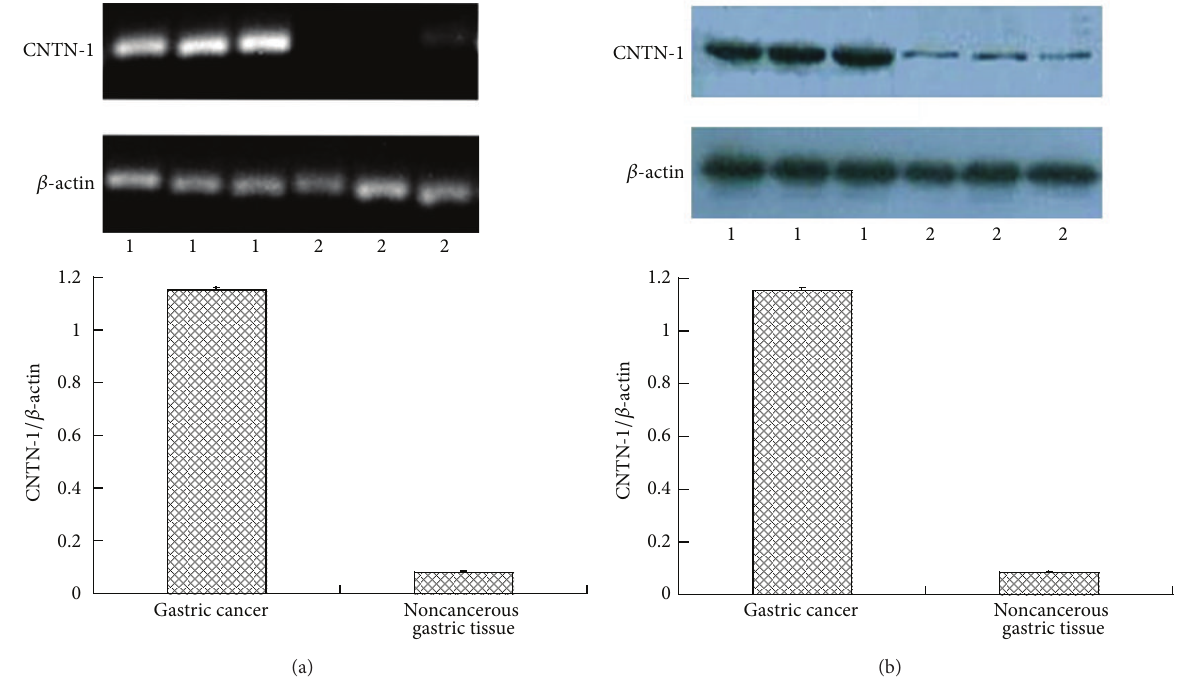
Figure 1: Expression of CNTN-1 mRNA (a) and CNTN-1 protein (b) in gastric cancer. (a) Semiquantitative RT-PCR for expression of CNTN- 1 mRNA in gastric cancer. 𝛽 -actin was applied to internal control (1: gastric cancer group; 2: noncancerous gastric tissue group). Tumour samples expressed higher level of CNTN-1 mRNA than that in noncancerous gastric samples ( 𝑃 < 0.001 ). (b) Western Blot for expression of CNTN-1 protein in gastric cancer. 𝛽 -actin was applied to internal control (1: gastric cancer group; 2: noncancerous gastric tissue group). Tumour samples expressed higher level of CNTN-1 protein than that in noncancerous gastric samples ( 𝑃 < 0.001 ).